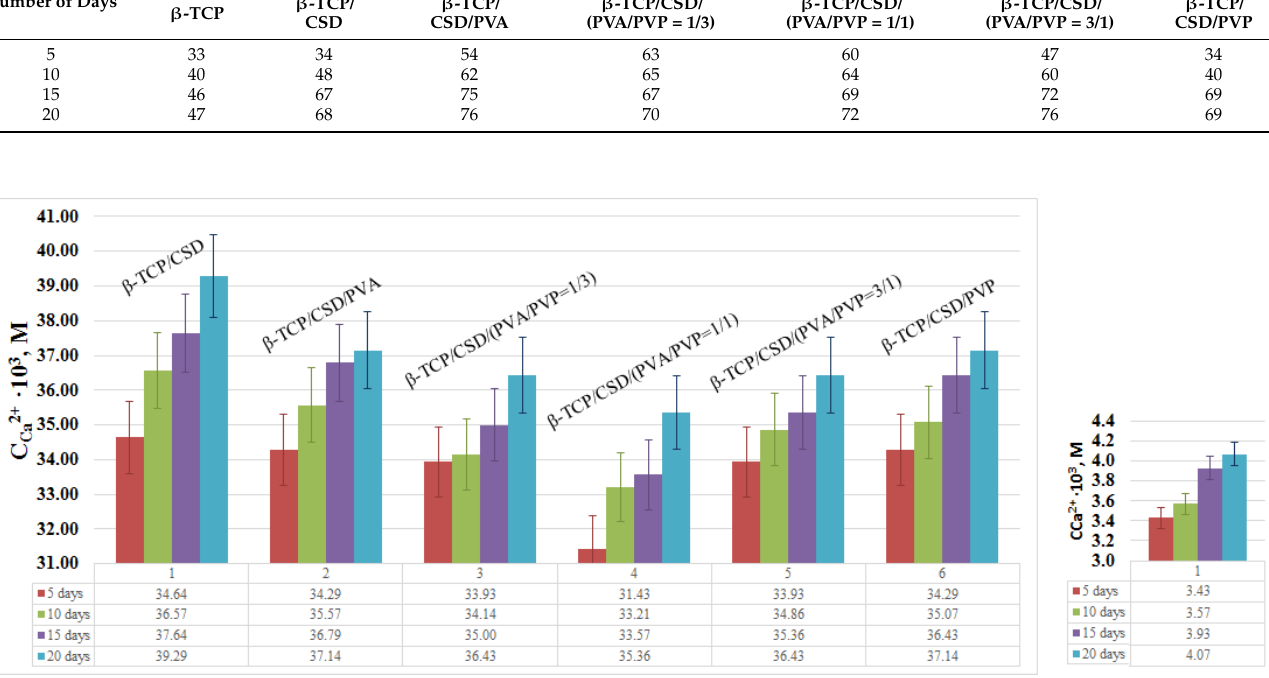
Figure 8. Viability of human macrophages in the presence of composite cement.